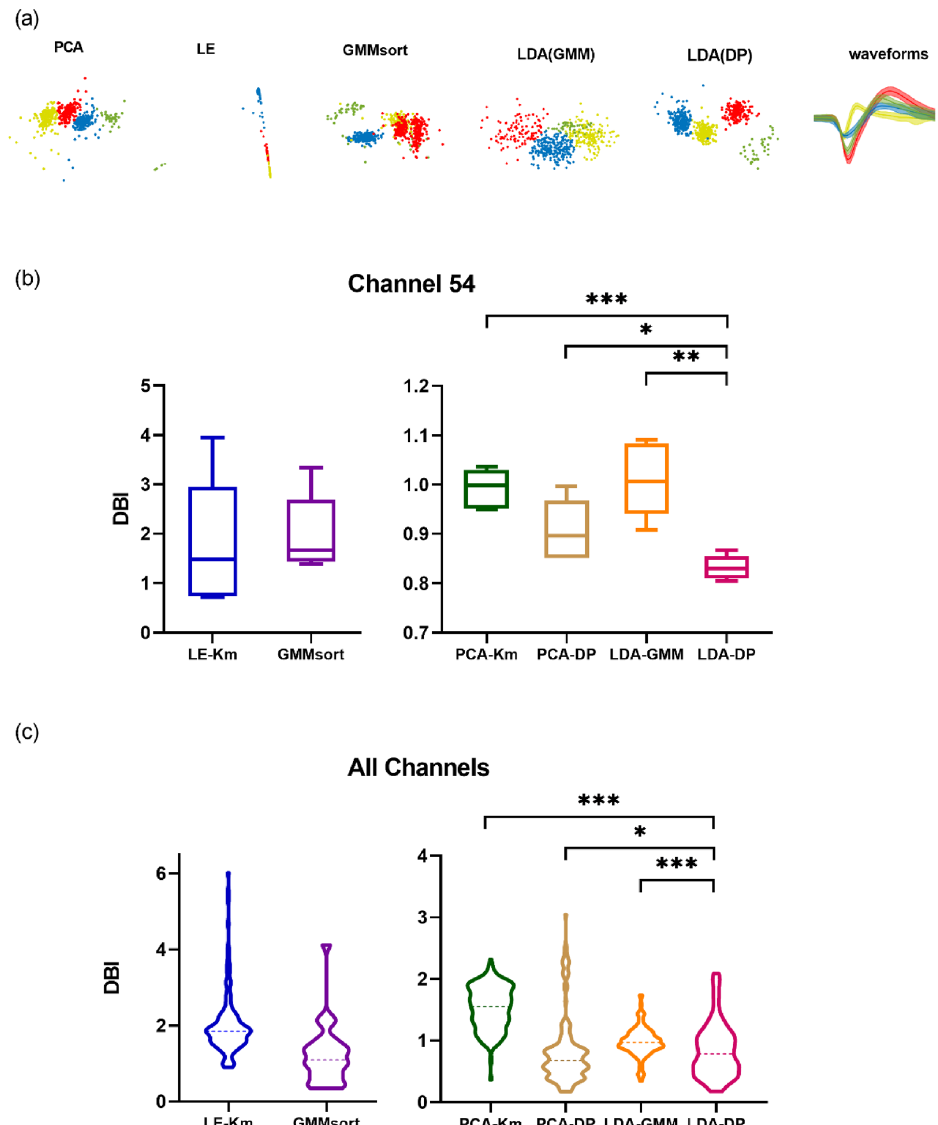
Figure 7. The sorting results on Dataset C when comparing 6 spike sorting algorithms. ( a ) Two-dimensional feature subspace extracted by each method. The data points are colored according to the sorting results, in which red, green, yellow and blue represent cluster 1, cluster 2, cluster 3 and cluster 4 respectively. The last column shows the average spike waveforms of four clusters obtained by LDA-DP, and the shaded part represents the standard deviation. ( b ) Comparison of cluster quality using spikes from one particular channel 54 in Dataset C. We conducted a fivefold cross-validation and draw boxplots of the DBI index for 6 algorithms. *p < 0.05, **p < 0.01, ***p < 0.001, Kruskal–Wallis test. ( c ) Comparison of cluster quality using spikes from all 30 channels in Dataset C. We conducted a fivefold cross-validation for each channel and then drew the violin plot. The dashed lines represent the median of the DBI. *p < 0.05, ***p < 0.001, Kruskal–Wallis